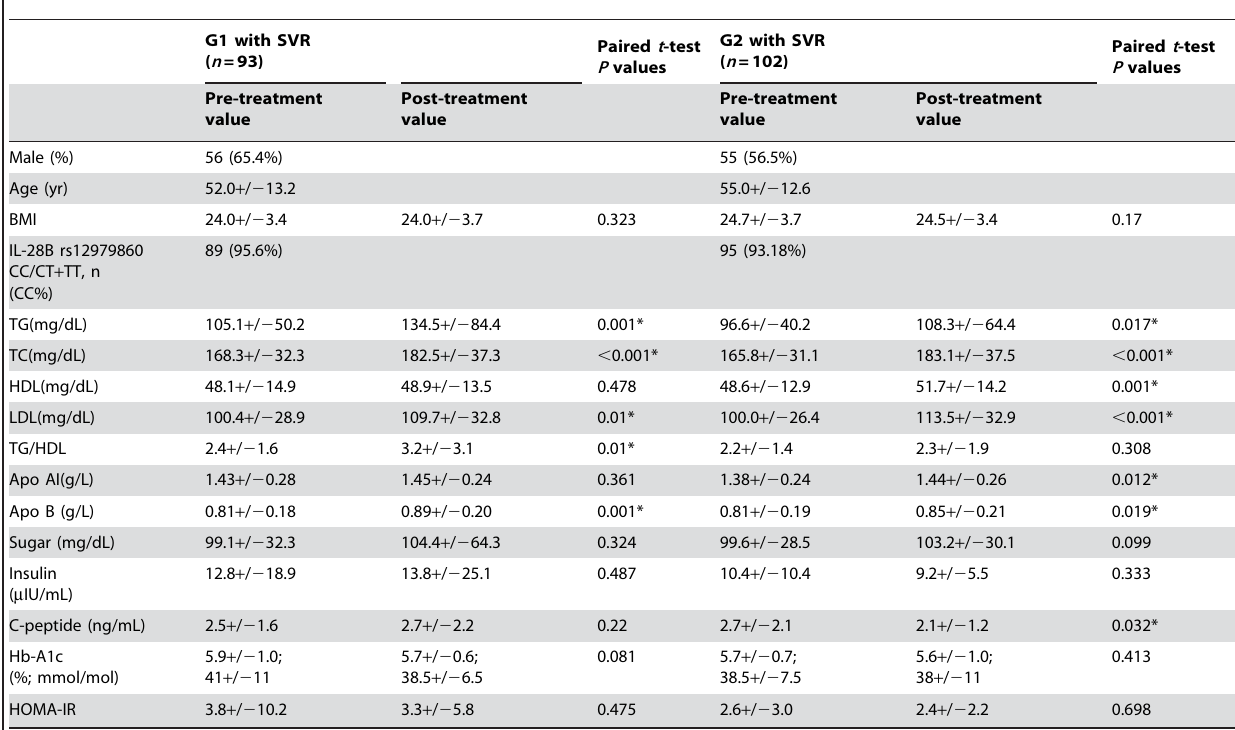
Table 3. Comparison of pre- and post-treatment variables in the CHC patients with SVR stratified by genotype.